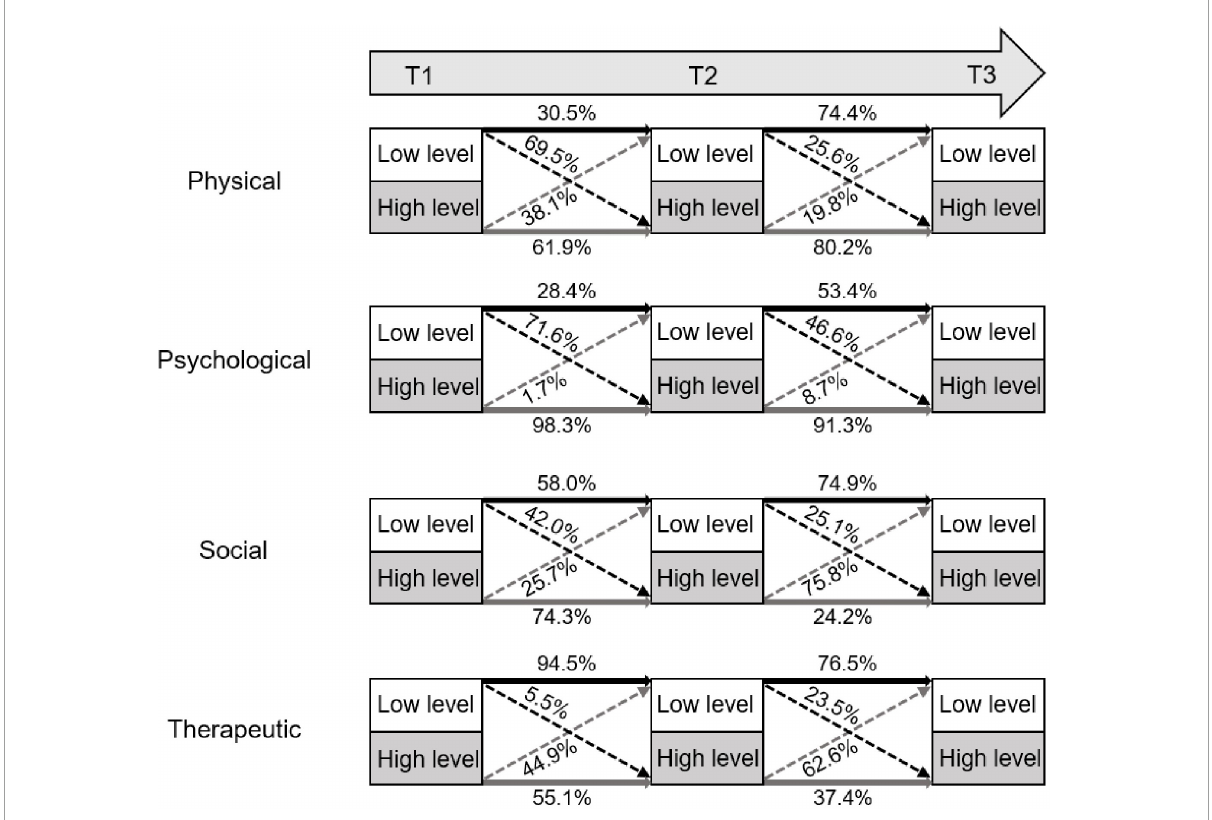
FIGURE3 Latent transition trajectory of high and low levels in the four domains. It shows the state transitions over time in the different patient subgroups of the four